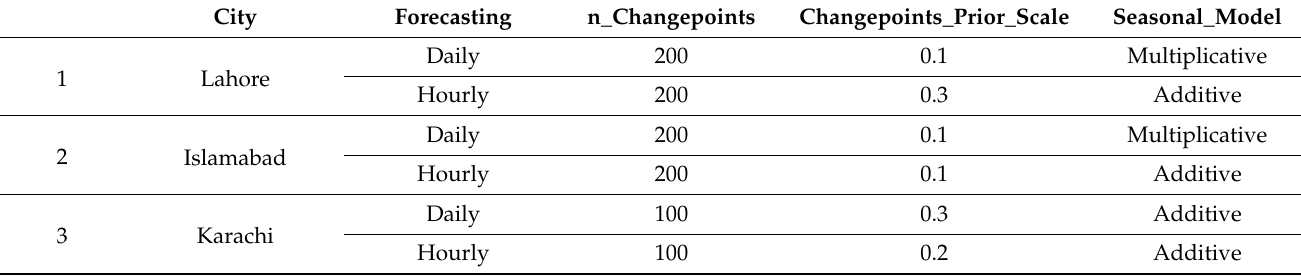
Table 2. Parameters used for training of the daily and hourly multivariate FbProphet model.